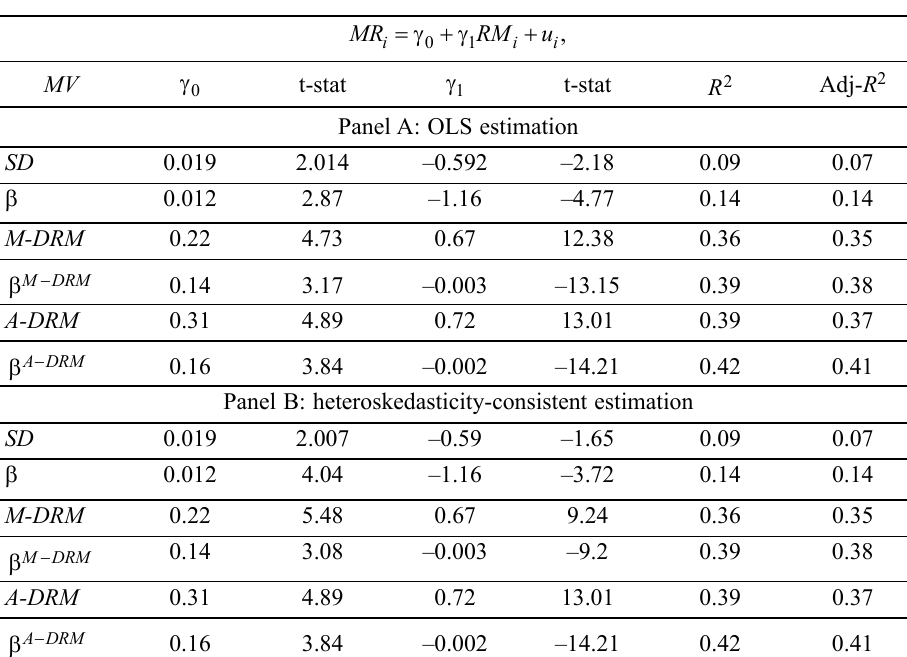
Table 3. Simple regression analysis upon full